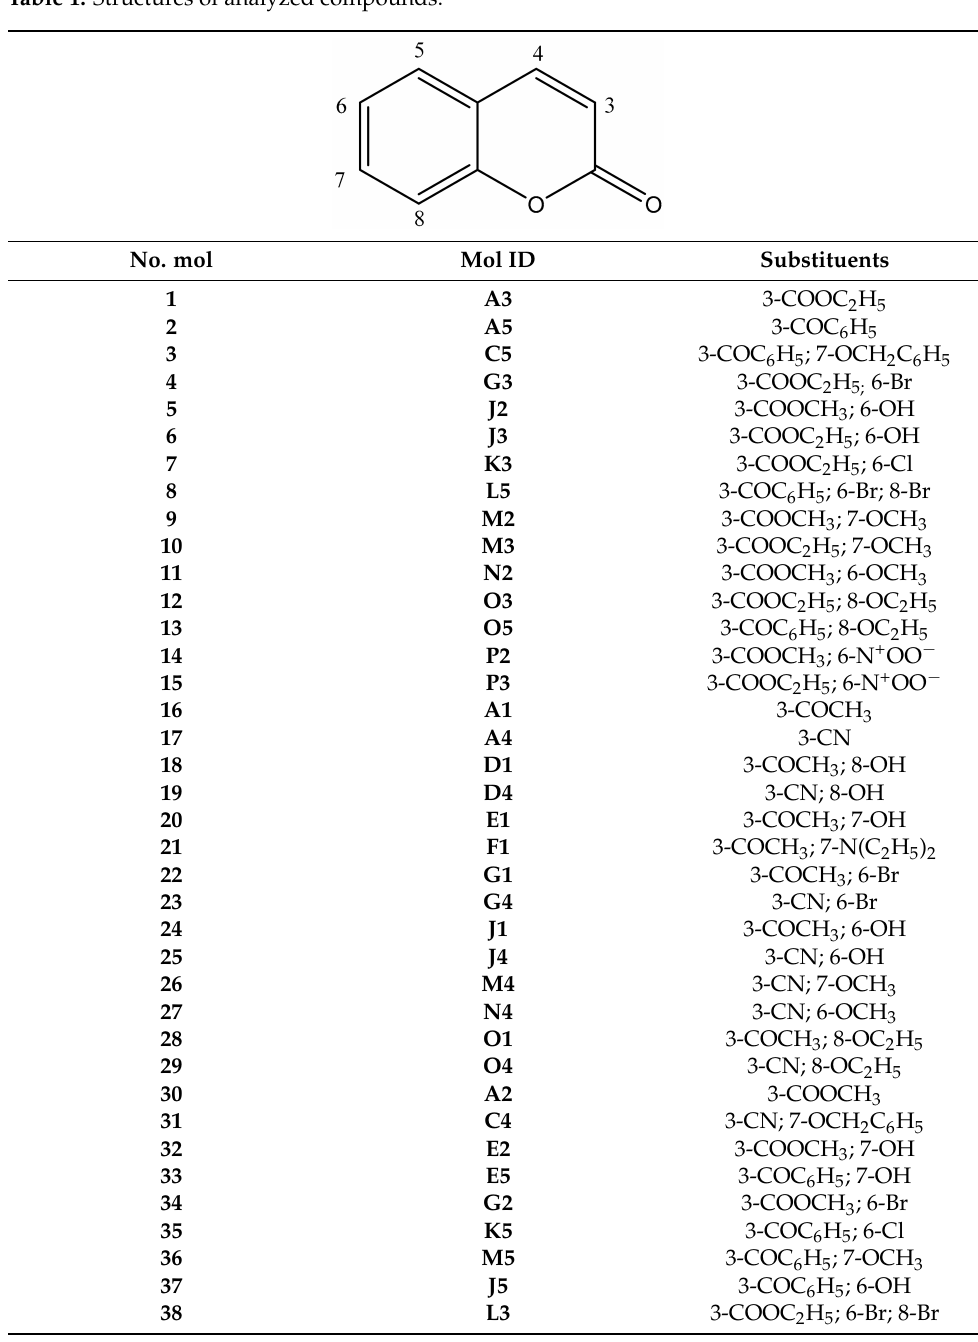
Table 1. Structures of analyzed